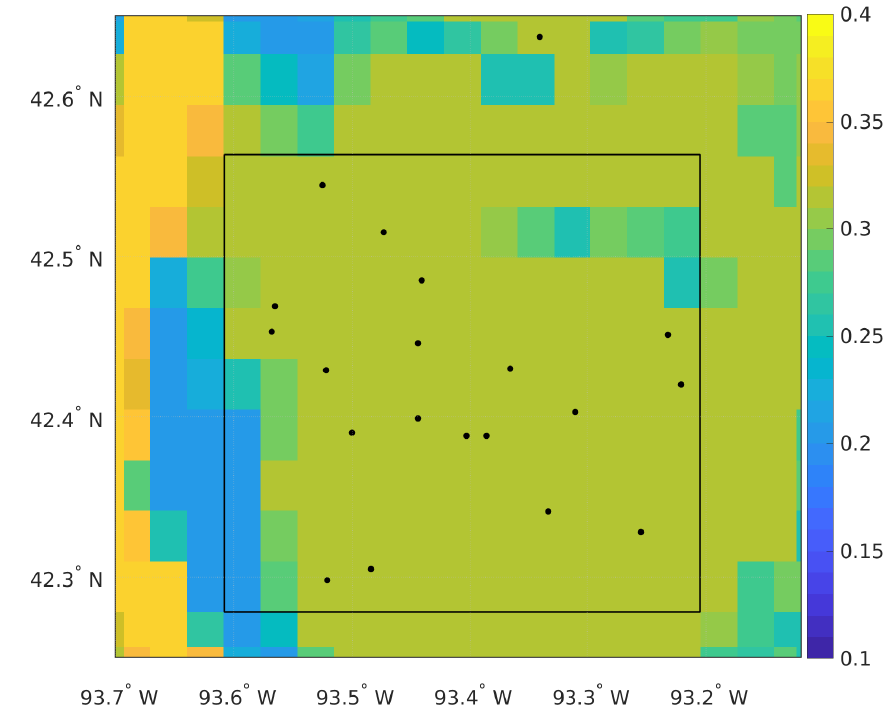
Figure 10. STATSGO-derived clay fraction as used by SMAP in the South Fork. The outlined region corresponds with the 33km radiometric domain and in situ stations presented in Figure